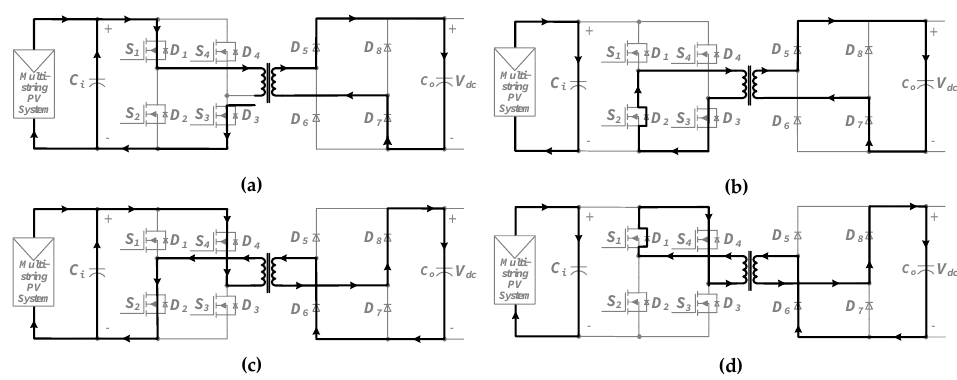
Figure 11. Operation modes of the MPPT converter for one complete cycle: ( a ) Mode 1: Power transfer in positive half-cycle; ( b ) Mode 2: Freewheeling in positive half-cycle; ( c ) Mode 3: Power transfer in negative half-cycle; and ( d ) Mode 4: Freewheeling in negative half-cycle.